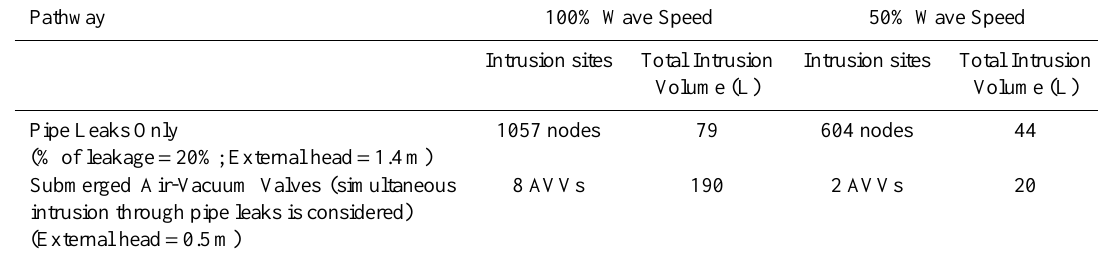
Table 2. Estimated intrusion volumes into the distribution system for two wave speed values in cast-iron mains.